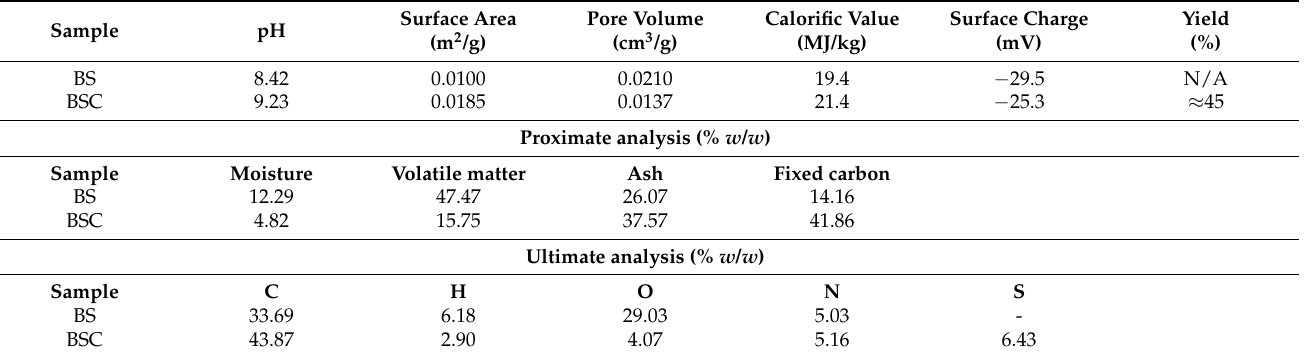
Table 2. Characteristic of BS and BS char